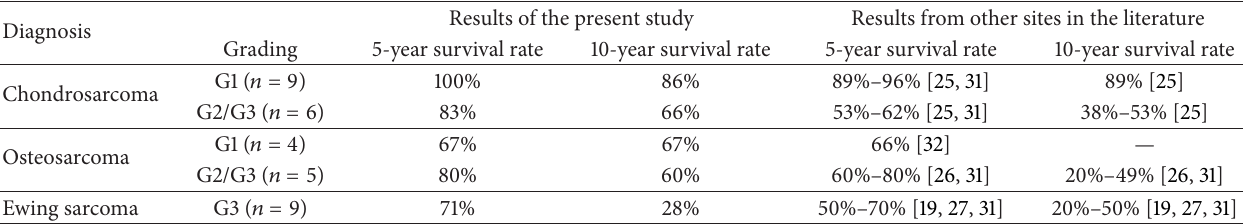
Table 3: Five- and 10-year survival rates of sarcomas of the foot compared with rates at other skeletal sites. Results of the present Diagnosis